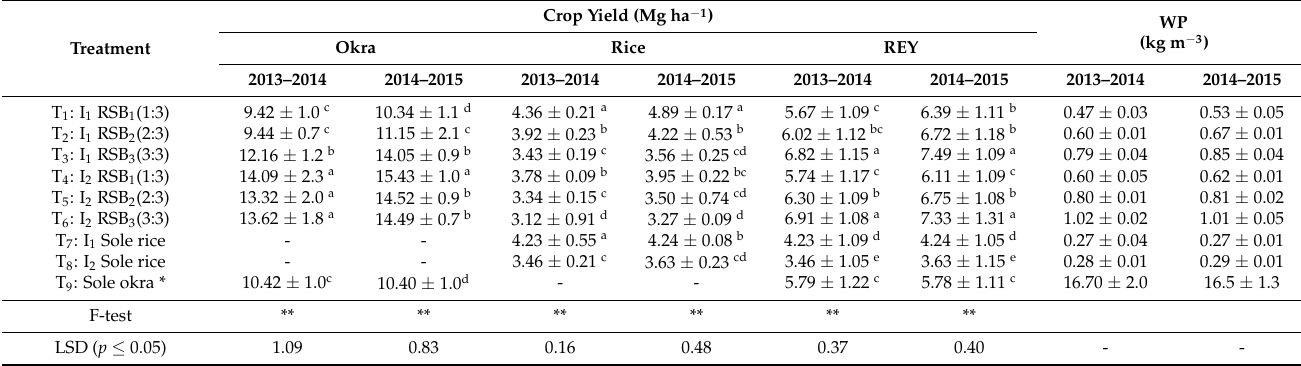
Table 3. Crop yield and water productivity (WP) of summer rice as influenced by land configuration and water management practices.